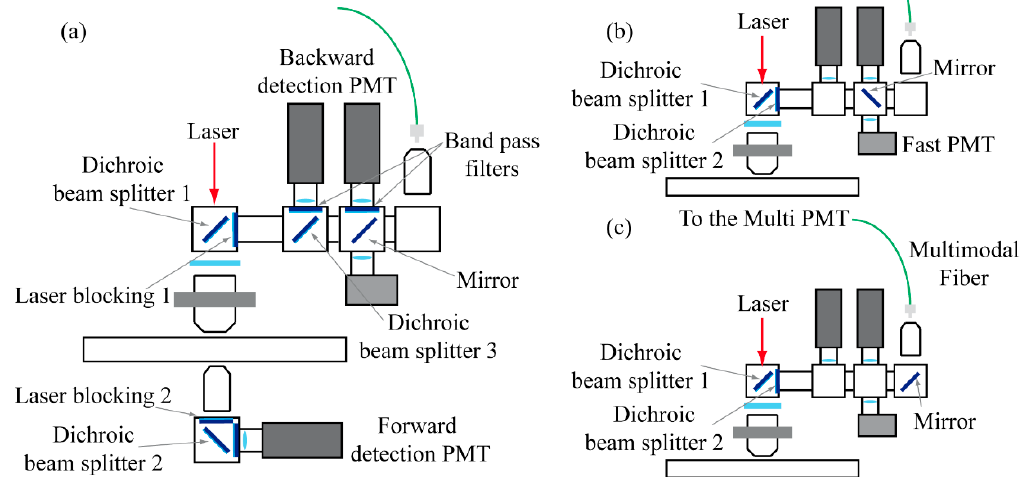
Figure 4. ( a ) Setup configuration used for MPM acquisitions, the signal can be collected both backward and forward. A system of filters makes it possible to separate the signal from the excitation and to detect each contrast mechanism onto a different PMT. ( b ) The setup configuration used for FLIM acquisitions. ( c ) The setup used for SLIM acquisition.